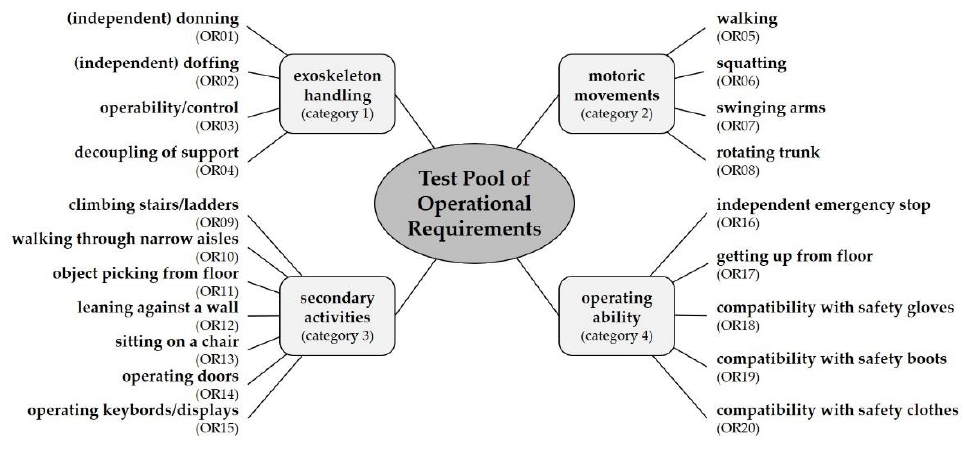
Figure 3. Test pool for evaluating operational requirements of industrial exoskeletons.